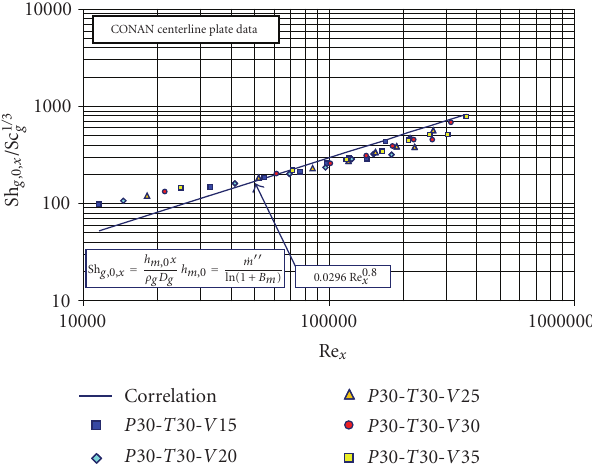
Figure 11: Comparison of a set of experimental data from the CONAN facility with an engineering correlation